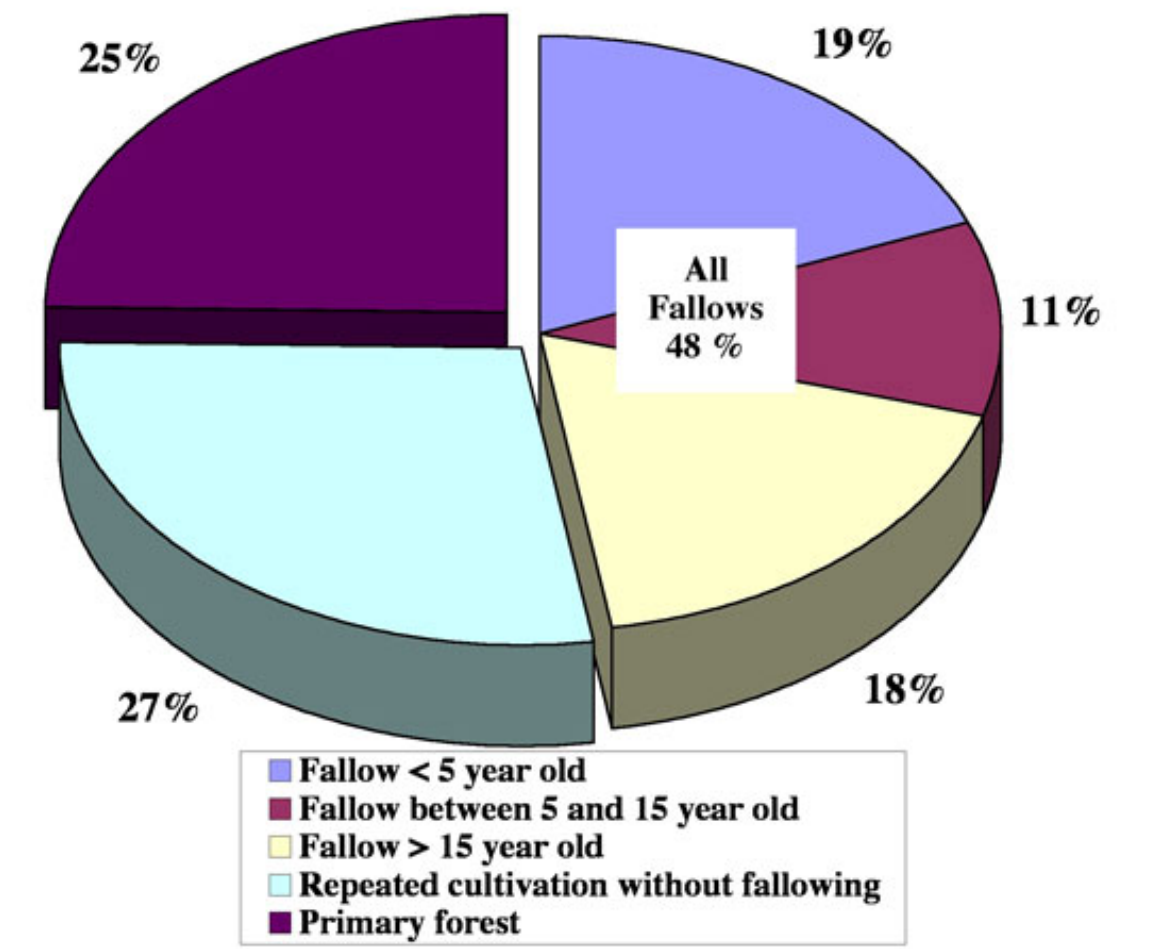
Fig. 2 . Percentages of land under different stages of fallow in Tubu villages in